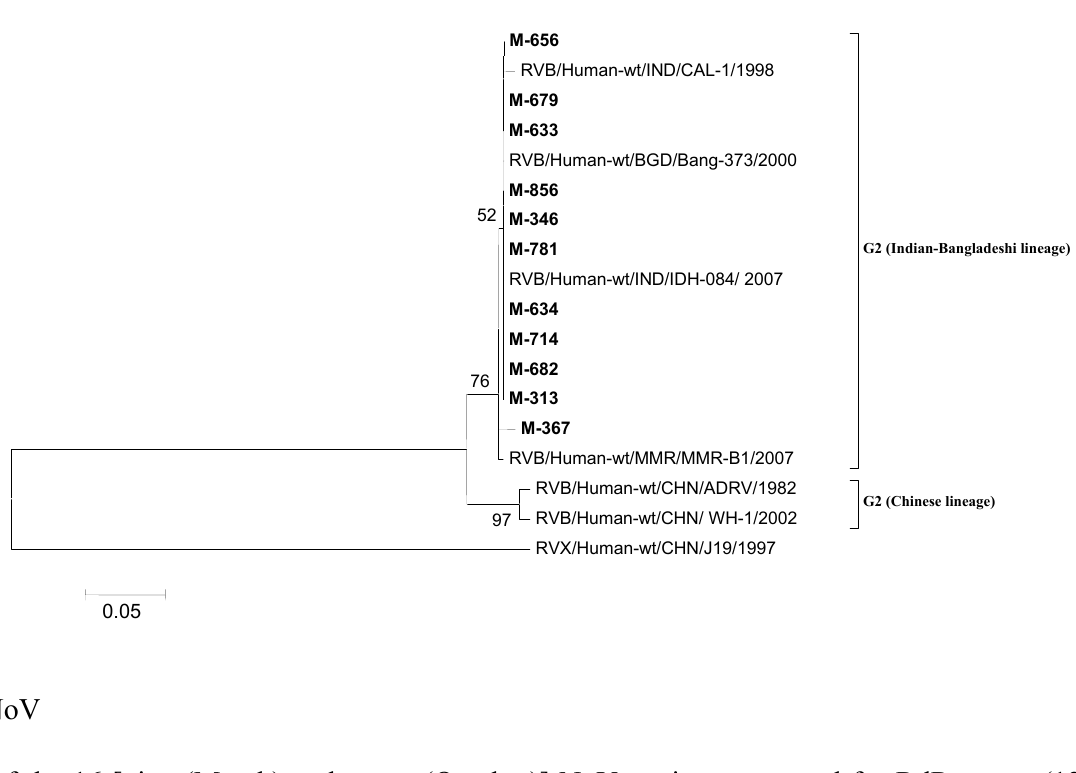
Figure 3. Phylogenetic tree based on the partial nucleotide sequences of NSP2 gene (150 bp) of RVB strains. The strains of the present study are in bold face. Scale indicates genetic